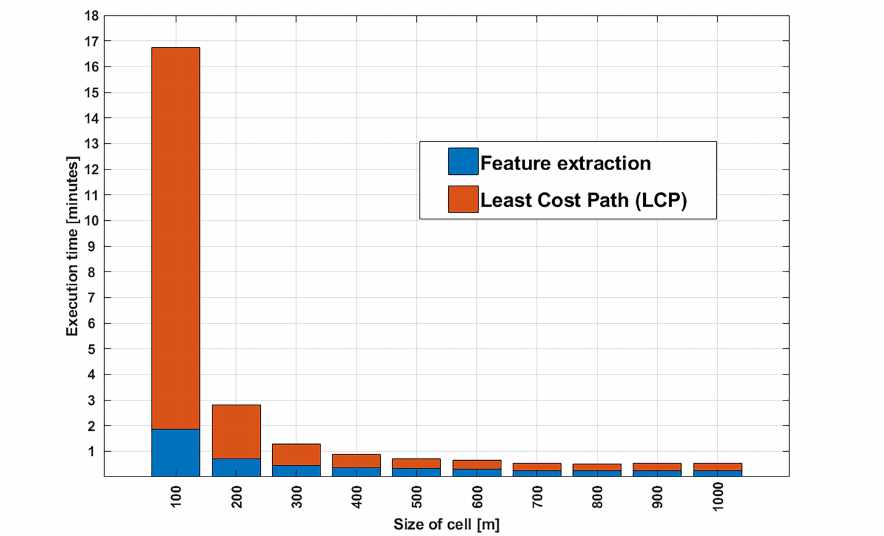
Figure 9. Computational time in minutes as a function of cell